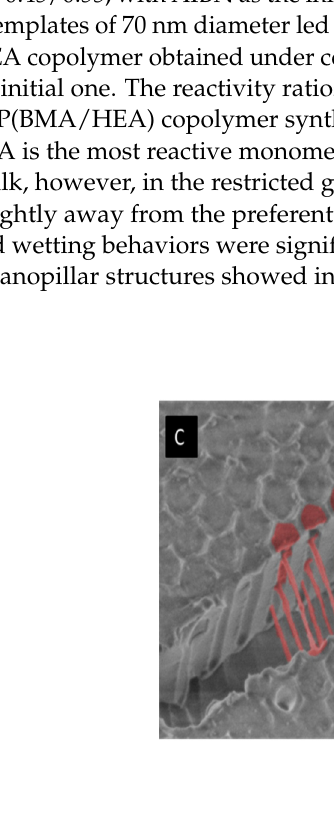
Figure 9. ( A ) Schematic copolymerization procedure of BMA and HEA monomers under confinement. ( B ) Infrared spectroscopy (IR) spectra of the copolymers obtained under confinement and in bulk. ( C ) SEM image of BMA ‐ HEA copolymer nanostructures [130]. Copyright 2019. Reproduced with permission from the publisher: MDPI.